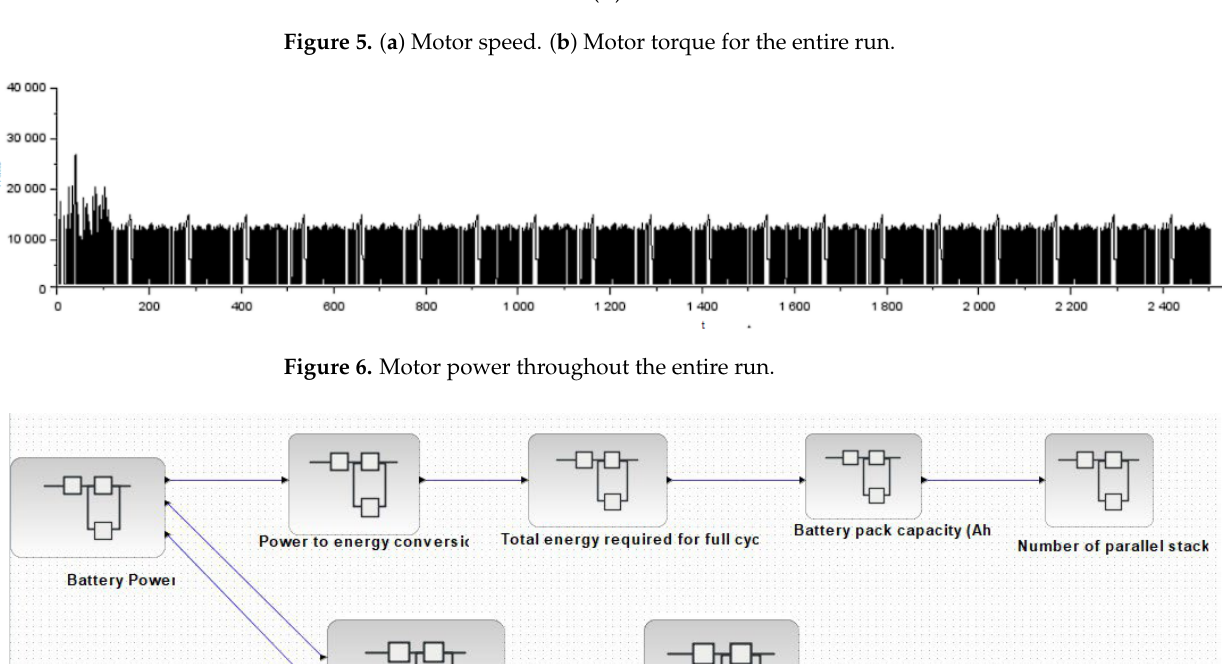
Figure 5. ( a ) Motor speed. ( b ) Motor torque for the entire run.